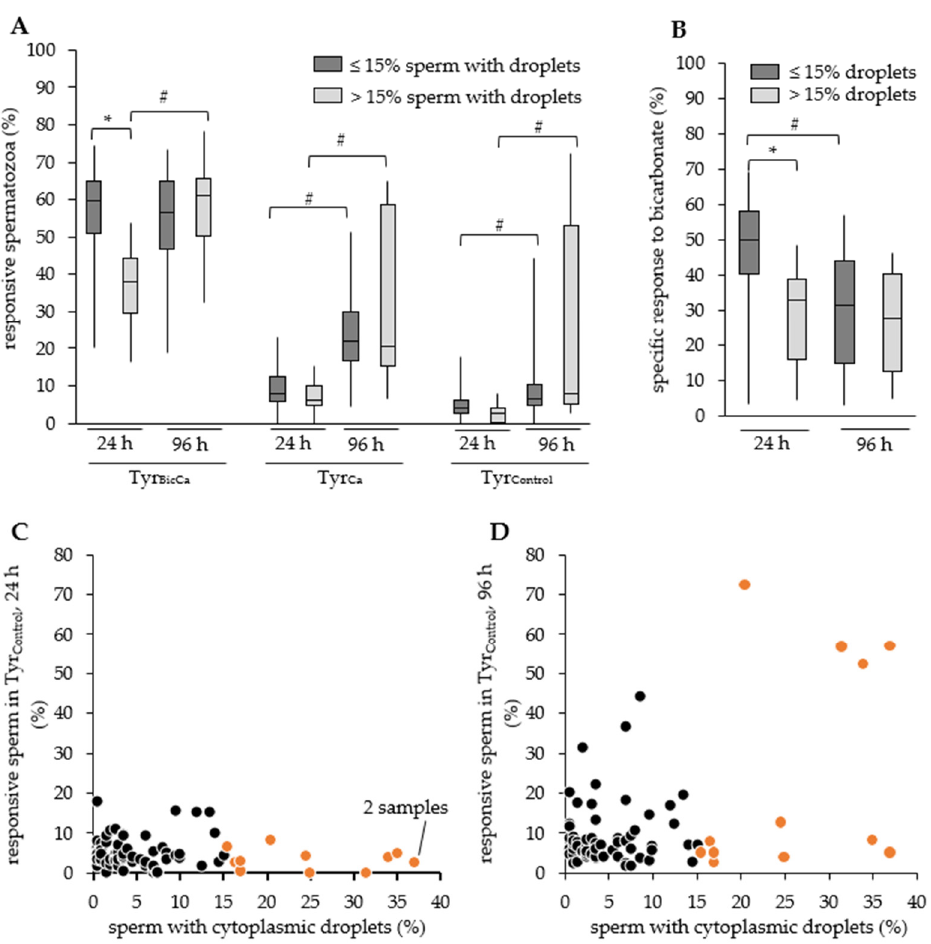
Figure 3. Storage effect on sperm responsiveness to capacitation stimuli in relation to the presence of sperm with cytoplasmic droplets. ( A ) Responsive spermatozoa in different media after 24 h or 96 h of semen storage for samples with ≤ 15% of spermatozoa with cytoplasmic droplets (n = 66 boars) or >15% of spermatozoa with cytoplasmic droplets (n = 12 boars). Responsiveness was calculated based on the propidium iodide- and Fluo-3-low sperm population as the difference ( ∆ ) between the values at the beginning (3 min) and after 60 min incubation ( ∆ 3–60 min = 3 min–60 min) in a capacitating medium with 15 mM bicarbonate and 2 mM calcium (Tyr BicCa ) or in non-capacitating variants with either 2 mM calcium (Tyr Ca ) or 1 mM EGTA (Tyr Control ). * indicates significant differences between the sample groups ( p < 0.05). # indicates significant difference for a given group between storage times ( p < 0.05). ( B ) The specific response to bicarbonate was calculated as the difference ( ∆ ) in response to a full capacitating medium (Tyr BicCa ) within 60 min minus the response to a calcium-containing control medium (Tyr Ca ) within 60 min. An asterisk indicates significant differences between the sample groups ( p < 0.05). A hash indicates significant differences for a given group between storage times ( p < 0.05). ( C , D ) Dot plot of the responsive sperm population after 24 h storage ( B ) or 96 h storage ( C ) in relation to the percentage of sperm with cytoplasmic droplets (proximal and distal) within a sample. Orange dots are samples with >15% of spermatozoa with cytoplasmic droplets (n = 12 boars).